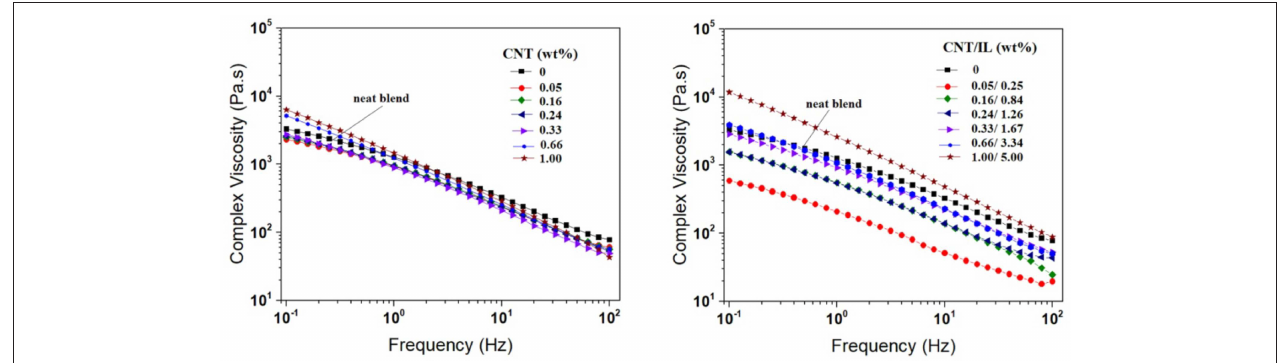
FIGURE 2 | Complex viscosity vs. frequency for the PS/PBAT composites as a function of the filler content.